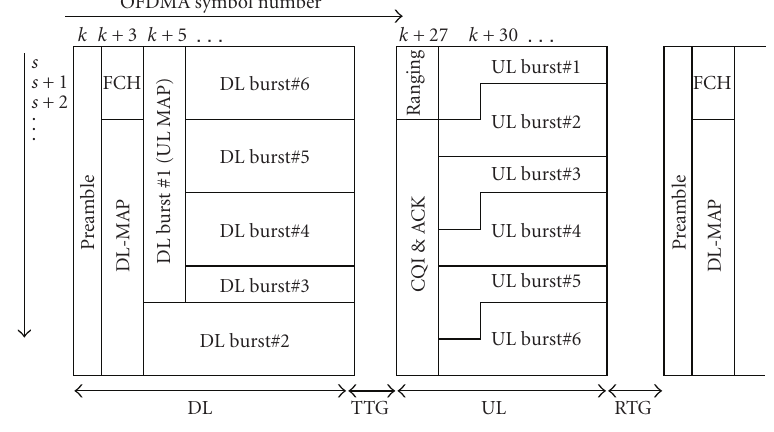
Figure 1: A Sample OFDMA frame